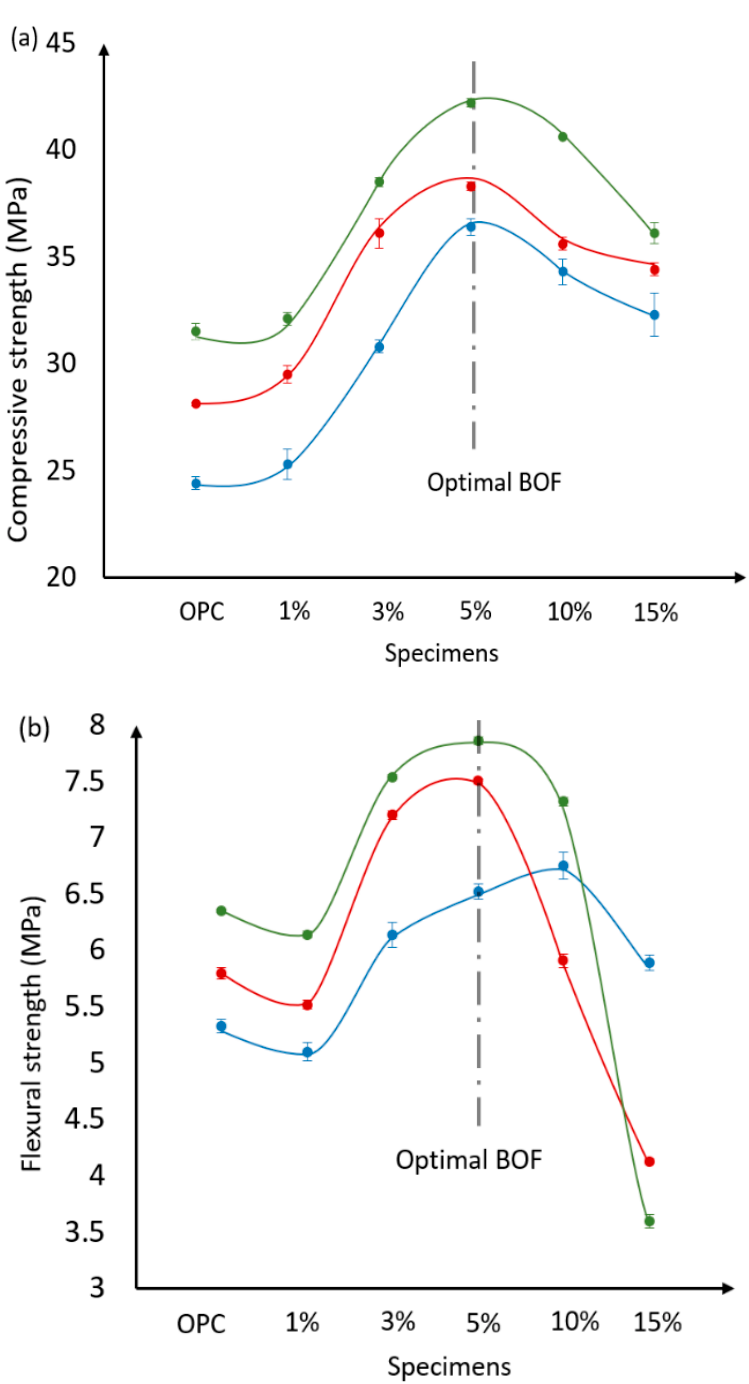
Figure 4. Distribution trends of the ( a ) compressive and ( b ) flexural strengths between the OPC and BOF-enabled cement.